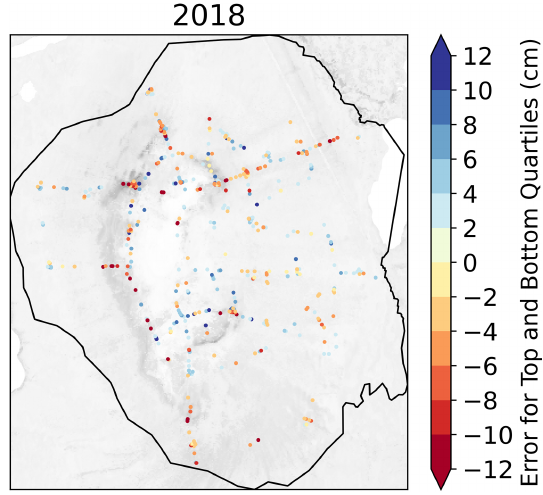
Figure A8. Spatial error (predicted minus observed) for the uppermost and lowermost quartiles of error in the random forest SWE prediction for the final model at Kougarok Hillslope. The error is not distributed systematically through space.